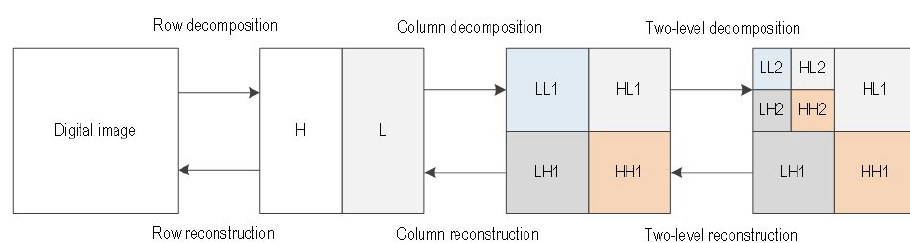
Figure 2. 2-D discrete wavelet decomposition and reconstruction of image.